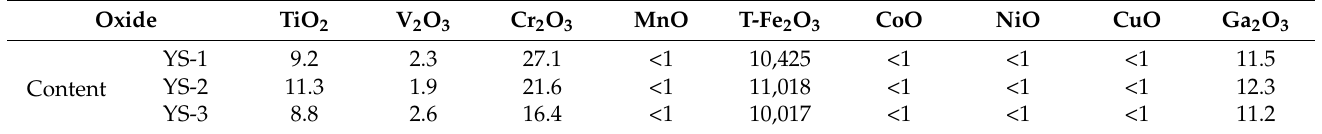
Table 1. Test results of transition metal elements of yellow sapphire (ppm